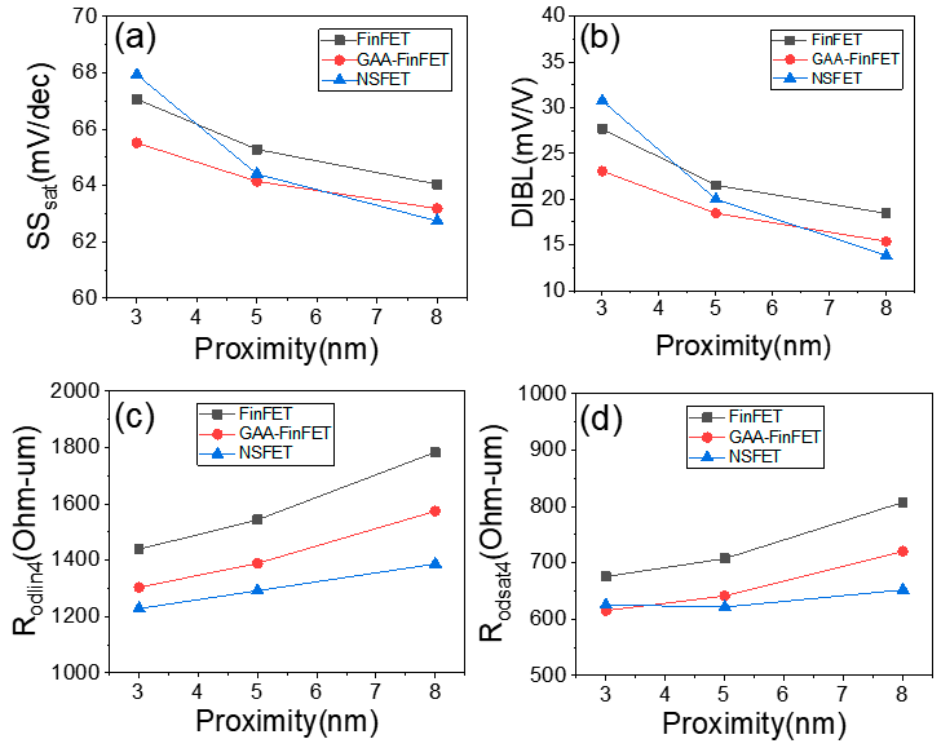
Figure 5. ( a ) SS sat , ( b ) DIBL, ( c ) R odlin4 , and ( d ) R odsat4 for three values of proximity (i.e., 8 nm, 5 nm, and 3 nm). Please note that the doping concentration in the sub-channel region is set to 1 × 10 18 cm − 3 .